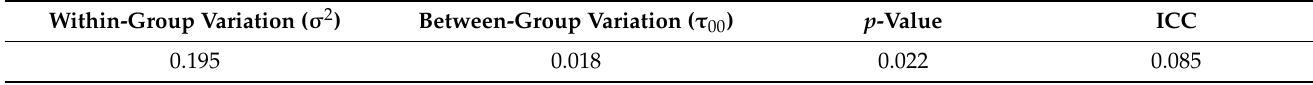
Table 3. The null model statistics of green purchase